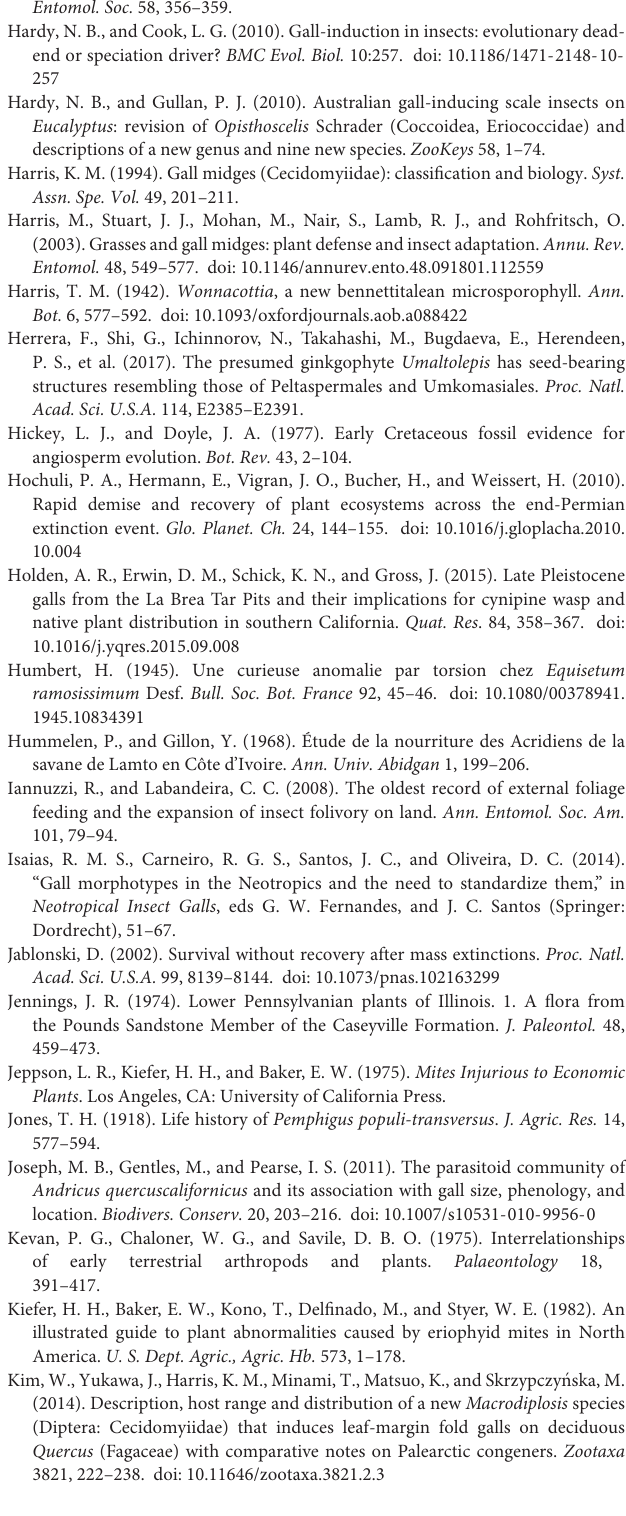
Frontiers in Ecology and Evolution |